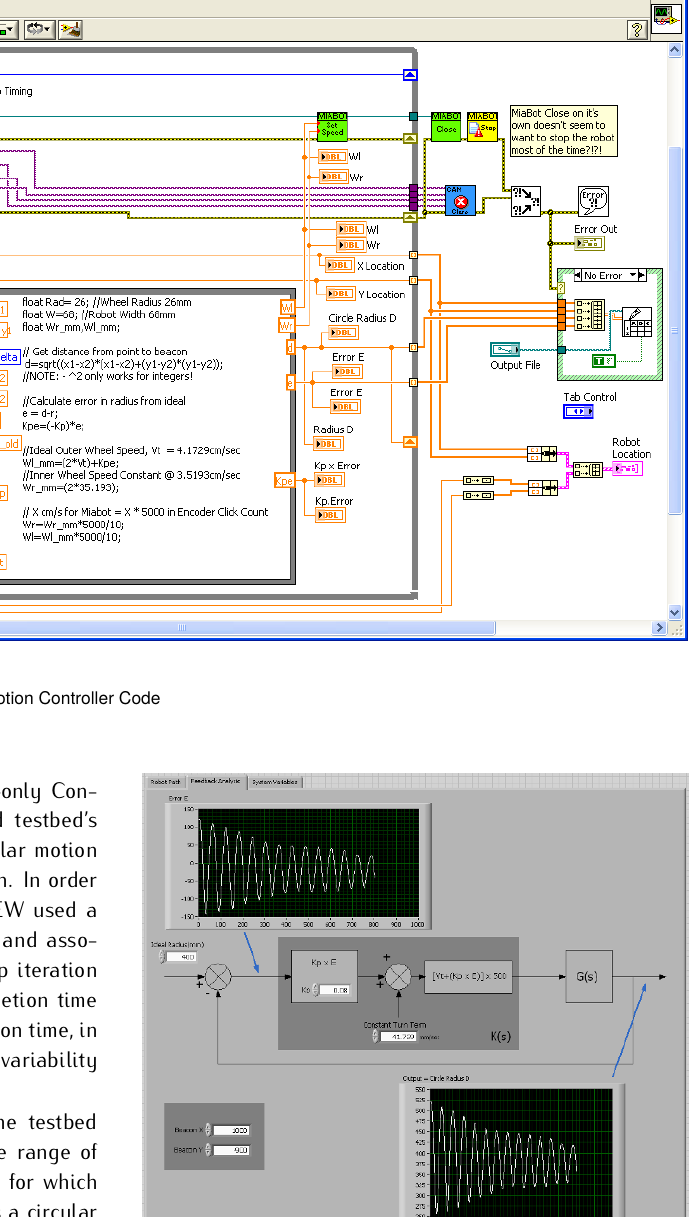
Figure 16. TypicalSystemNavigationusingtheProportionalControl implementation